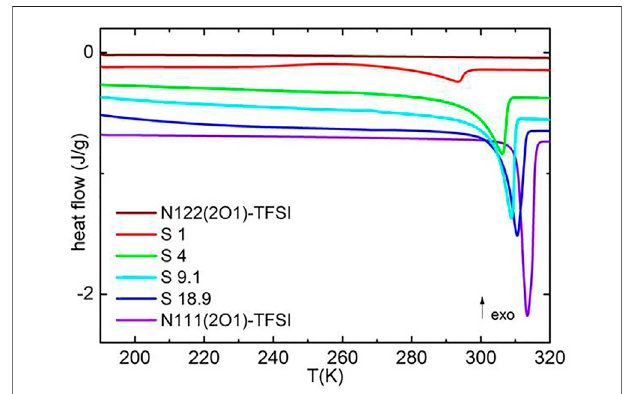
Figure 4displays the infrared absorbance spectra of N111(2O1)- TFSI,N122(2O1)-TFSI and the four mixtures, measured